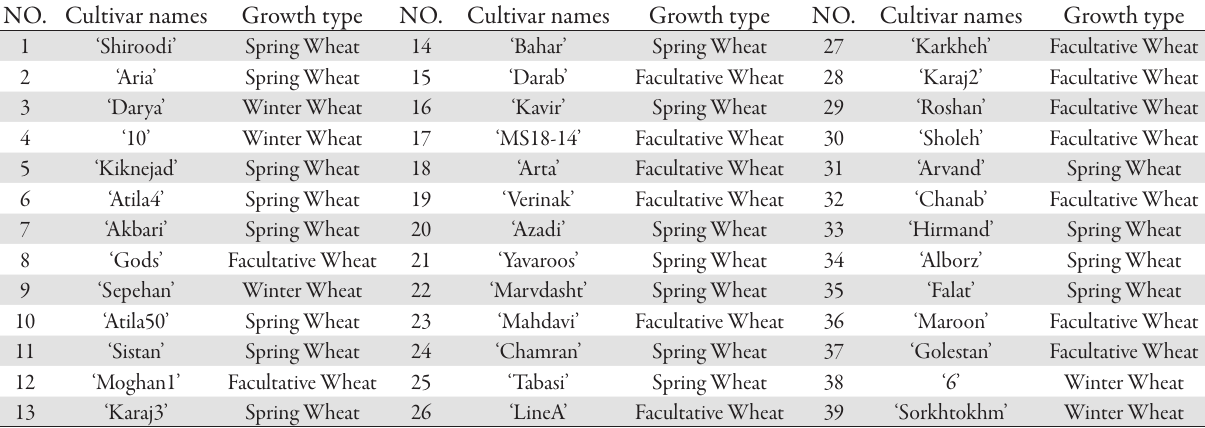
Tab. 1. The list of cultivars name and their growth